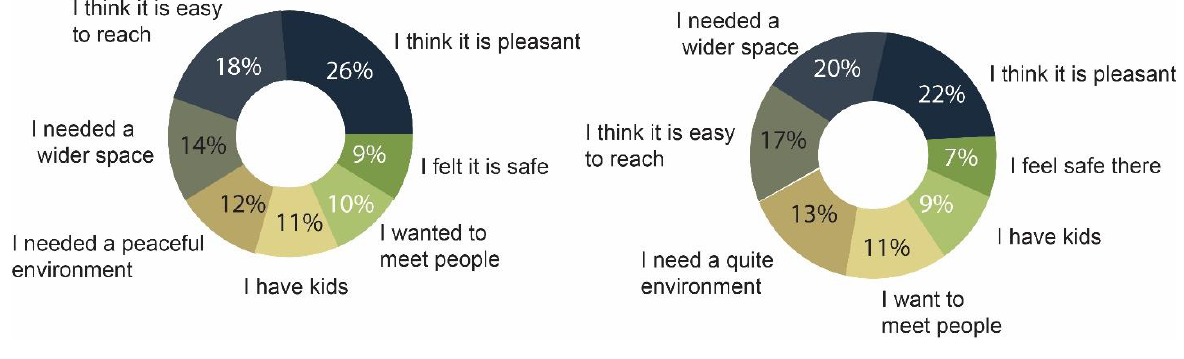
Figure 8: Why do you use the public space? Before the pandemic (Left) during the pandemic (Right). (Source: The author, 2021.)